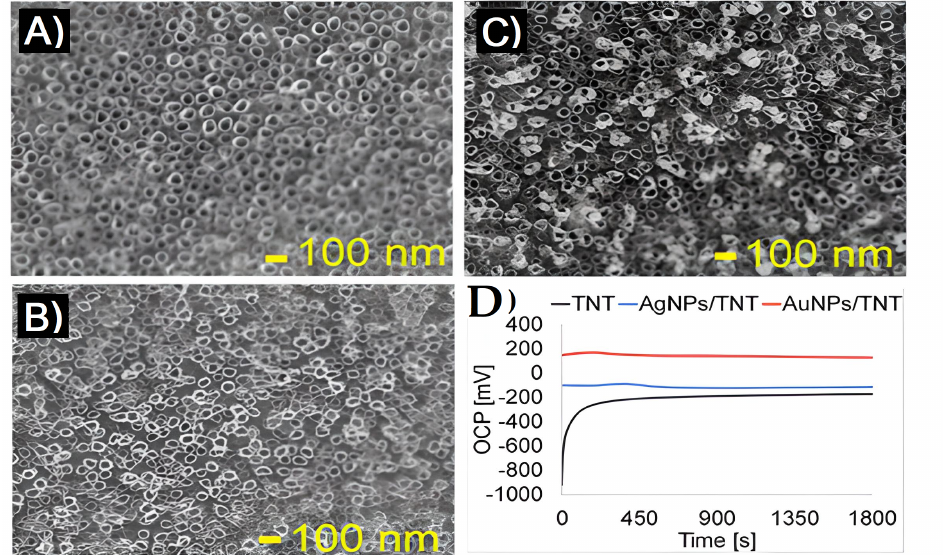
Figure 8. In the anatase phase of TiO 2 NTs, SEM analysis revealed a uniform, vertically oriented layer of NTs with a diameter of 50 ± 5 nm and a height of 1000 ± 100 nm nm, m, a surface area of 30.27 cm 2 , and a TNT density of 4.26 g/cm 3 ( A – C ). No breaking or delamination of the TNT layer occurred throughout the 2-hour annealing process, which was performed in an argon